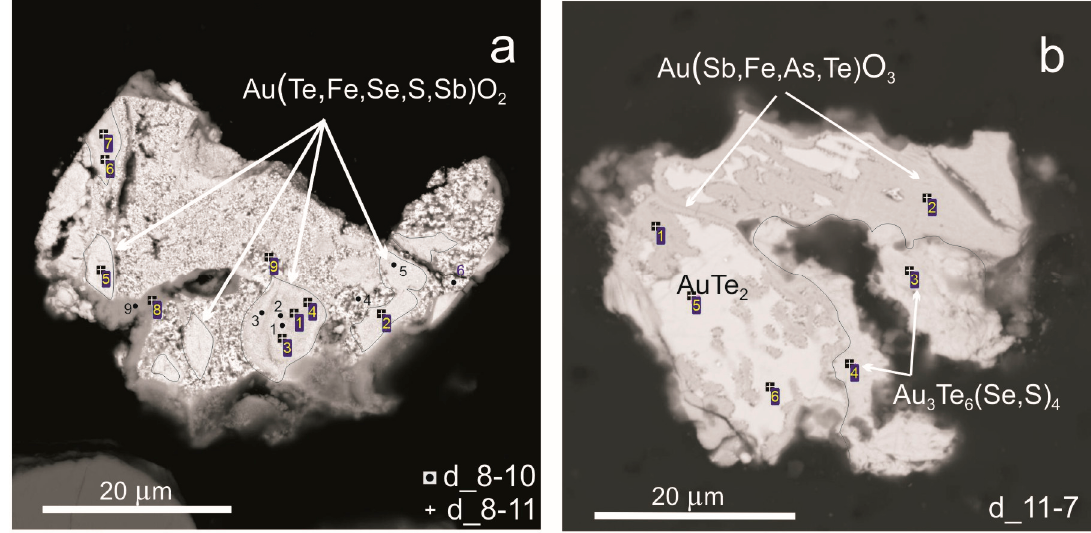
Figure 8. SEM images of complex oxides: zonal Au tellurates in association with mustard gold ( a ) and homogeneous Fe-rich auroantimonate Au(Sb,Fe)O 3 in association with calaverite (AuTe 2 ) and maletoyvayamite (Au 3 Te 6 (Se,S) 4 ( b ). 1–11—the compositions of compounds or mixtures in the analyzed sites are presented in Table 7.